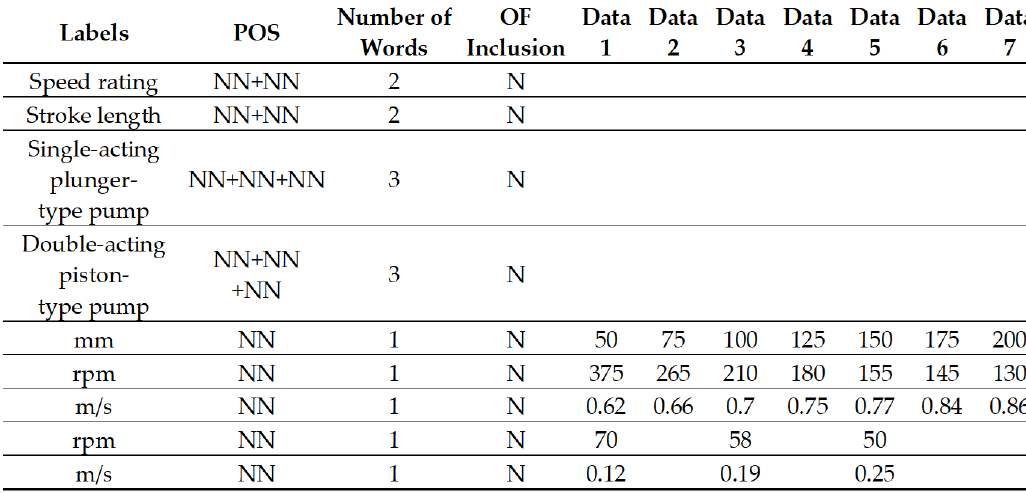
Figure 8. A pre-processing example for the table in Figure 1.